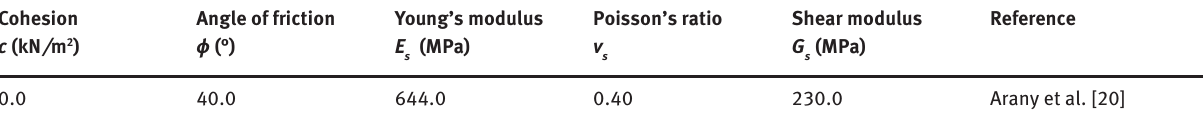
Table 3: Soil strength and deformation parameters at North Hoyle site.